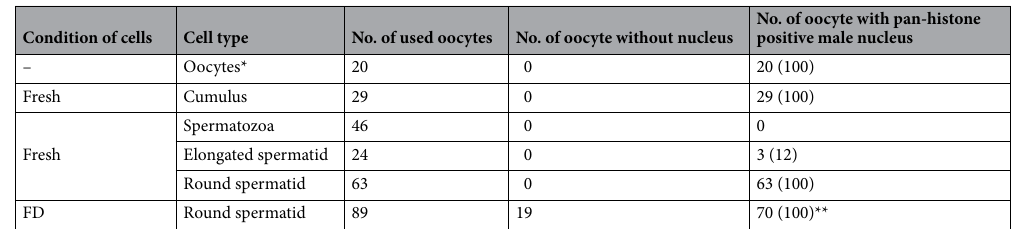
Table 4. Detection of pan-histone in the injected cell nucleus into oocytes. *MII spindle of intact oocyte were examined as positive control. **This ratio was calculated against nuclear existed oocytes.